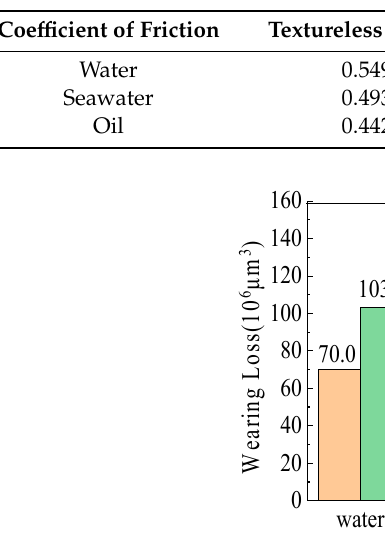
Table 1. The coe ffi cients of friction of pits with di ff erent pitches.